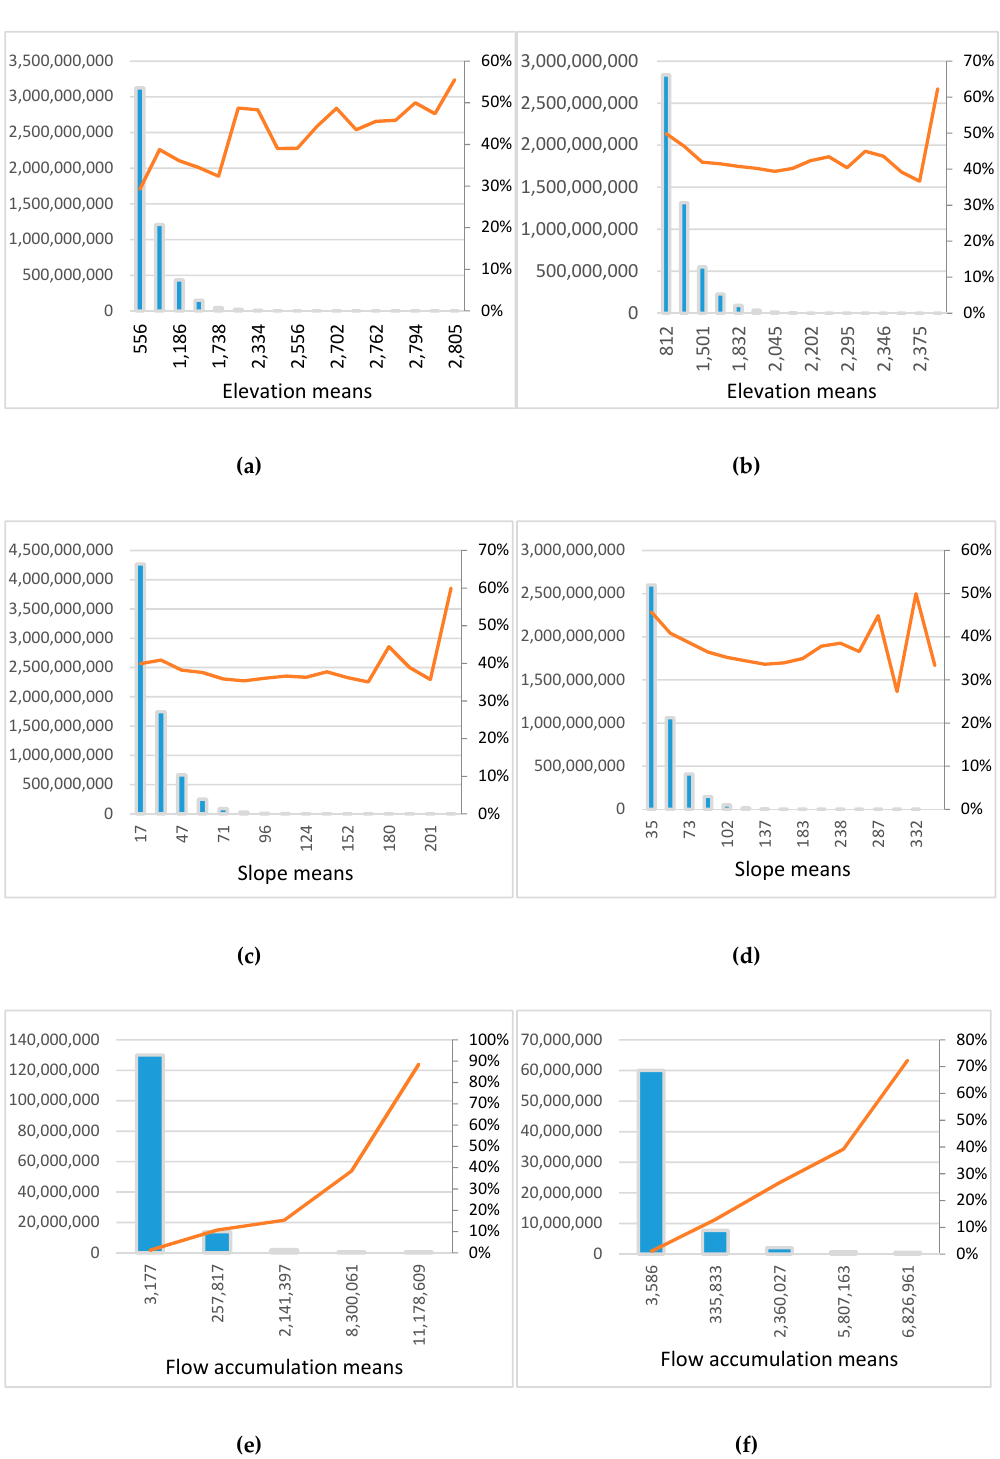
Figure 10. Head group extent (denoted by the columns; in m 2 ) and percentage (denoted by the lines) vs. partition means for: ( a ) Pinios elevation; ( b ) Acheloos elevation; ( c ) Pinios slope; ( d ) Acheloos slope; ( e ) Pinios flow accumulation; ( f ) Acheloos flow accumulation.